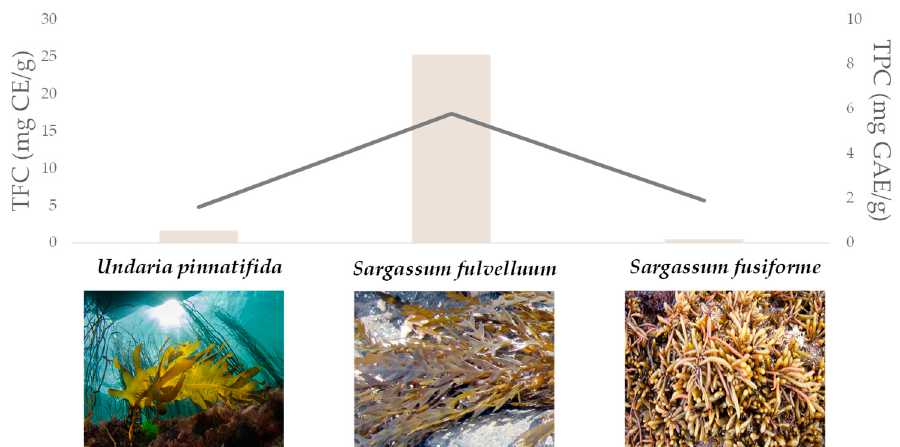
Figure 6. Algal species affecting rumen fermentation parameters TPC and TFC [96]. TPC = total phenol content; TFC = total flavonoid content.